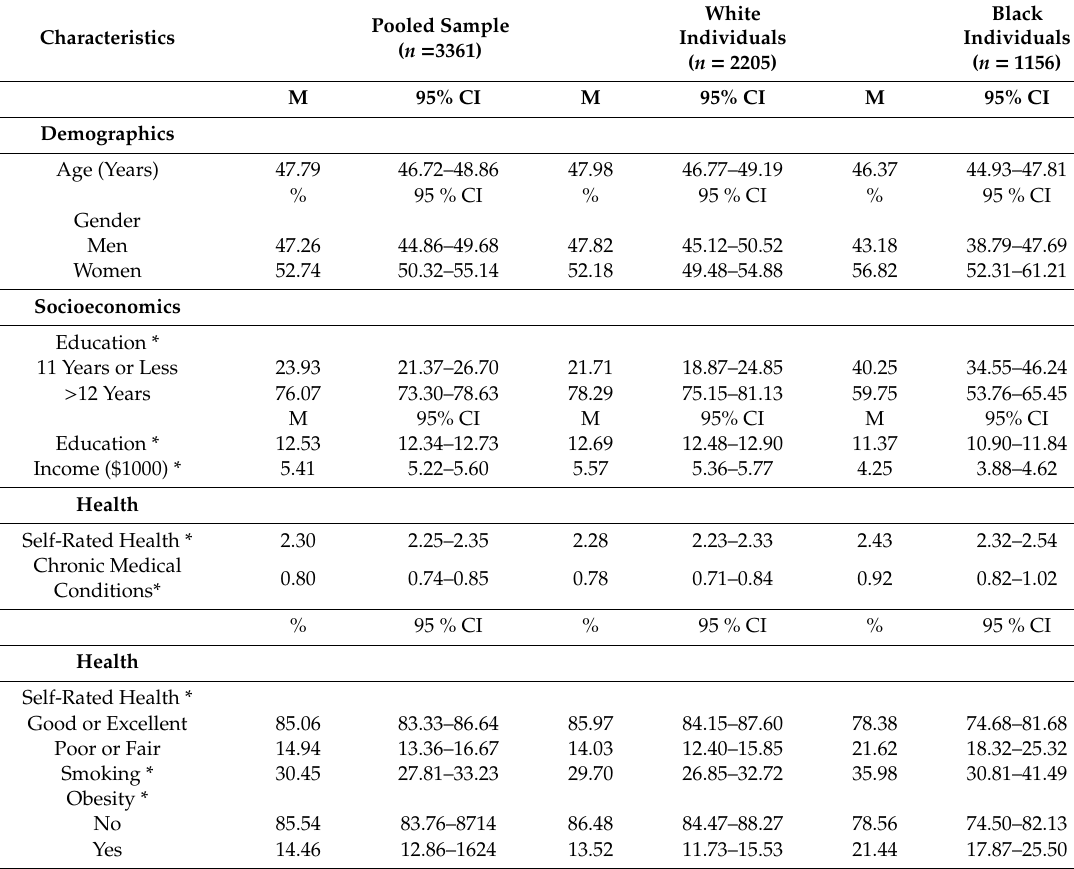
Table 1. Descriptive statistics in the pooled sample and also based on race ( n =